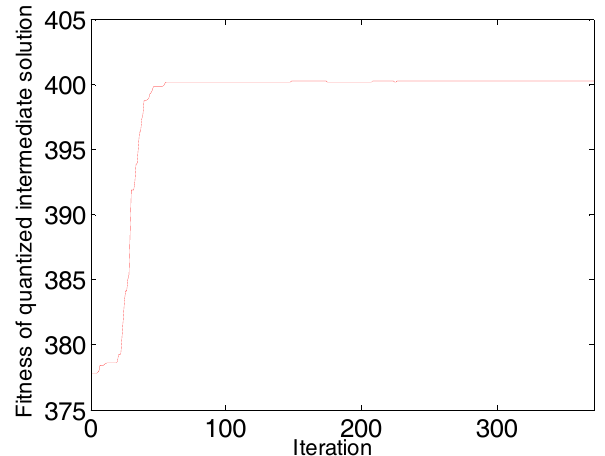
Figure 5. The convergence diagram of the AP algorithm (diesel data): Iterations vs. Fitness (net similarity) of quantized intermediate solution in the first round. When the iteration is 386, the network is converged.